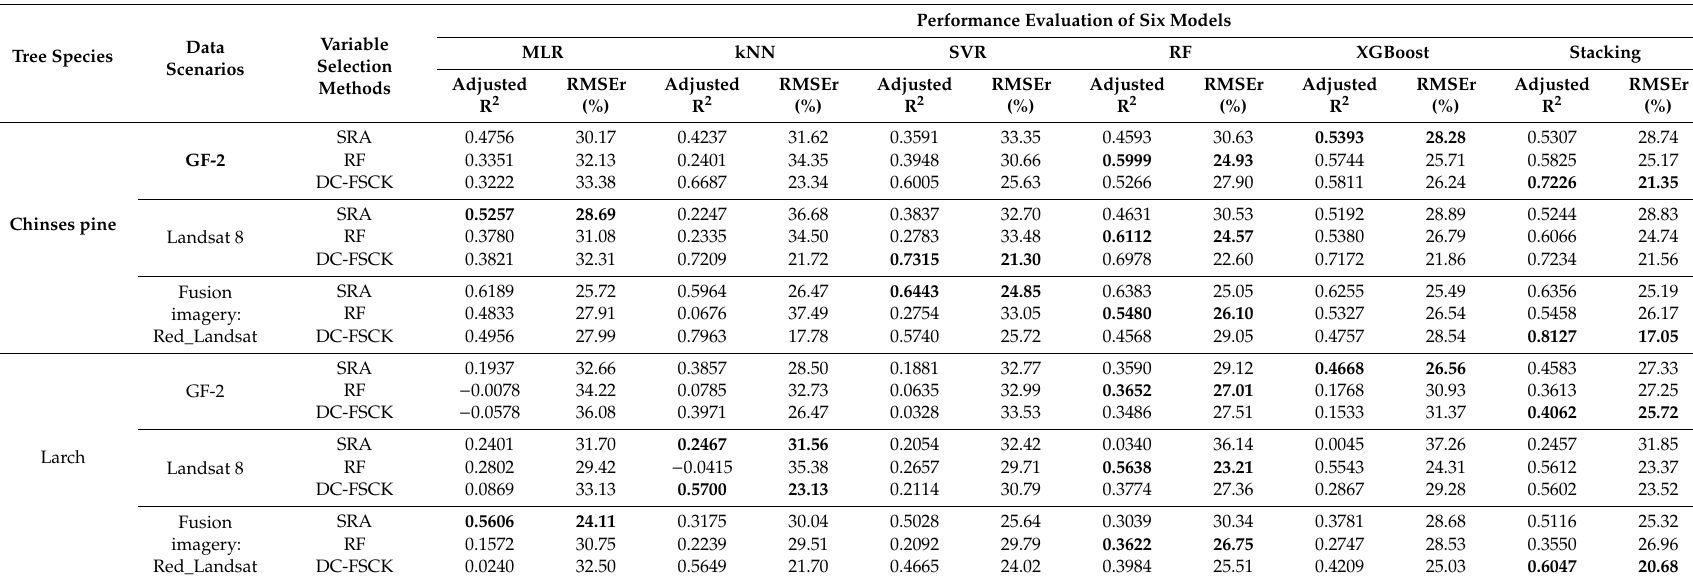
Table 6. Summary of the Adjusted R 2 and RMSEr for GSV estimation of Chinese Pine and Larch Plantations using three variable selection methods and six estimation models based on three datasets (Note: The numbers in bold indicate the model with the greatest Adjusted R 2 and smallest RMSEr value in the same data scenario).